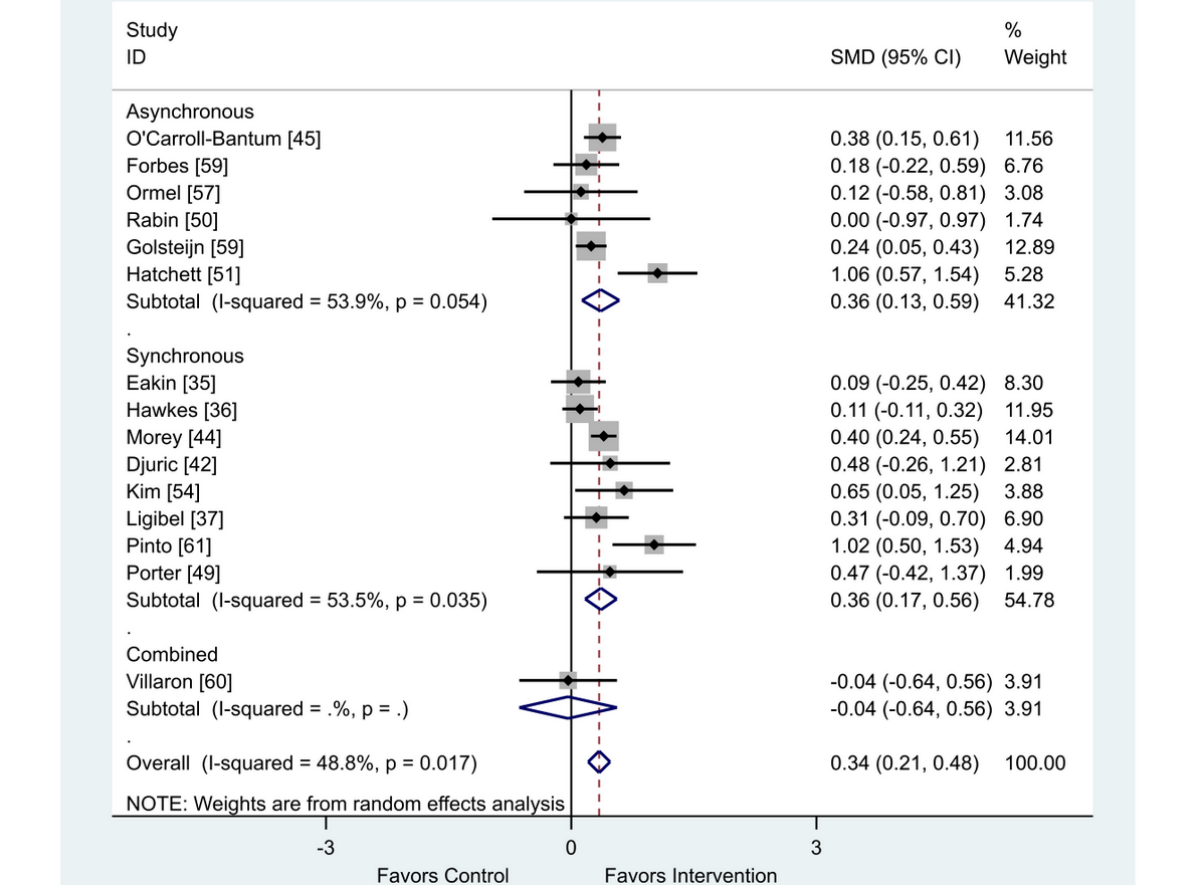
Figure 4. Effect of electronic health interventions compared with a control on physical activity interventions, analyzed using standardized mean difference. SMD: standardized mean